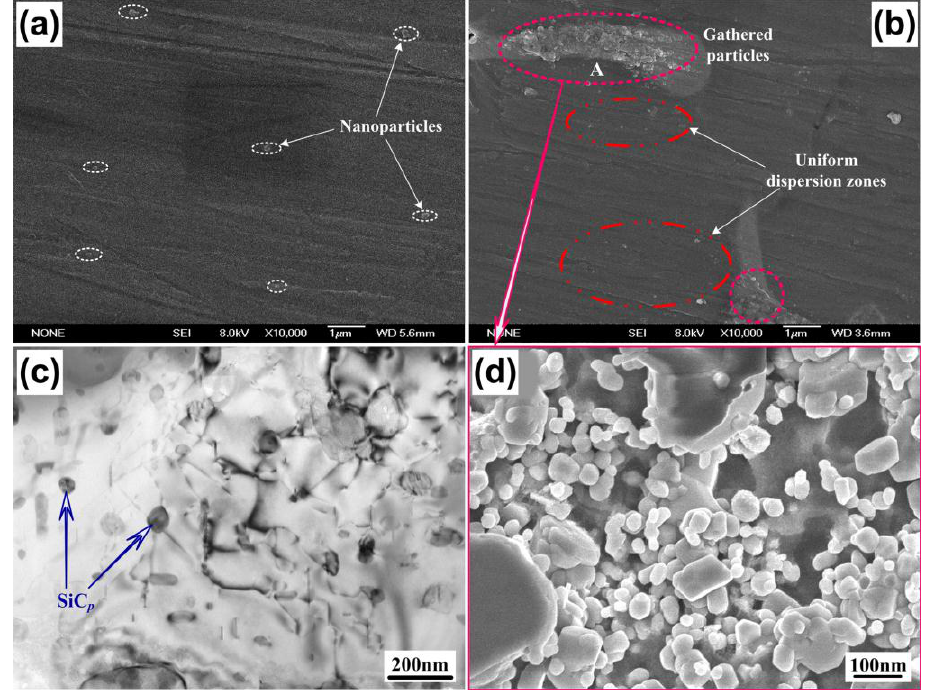
Figure 5. FESEM images of the ( a ) 3 wt. % and ( b ) 5 wt. % nano-sized SiC p /Al–Cu composite; ( c ) TEM micrographs of the 3 wt. % SiC p /Al–Cu composite; ( d ) the high magnification of area A in ( b ).